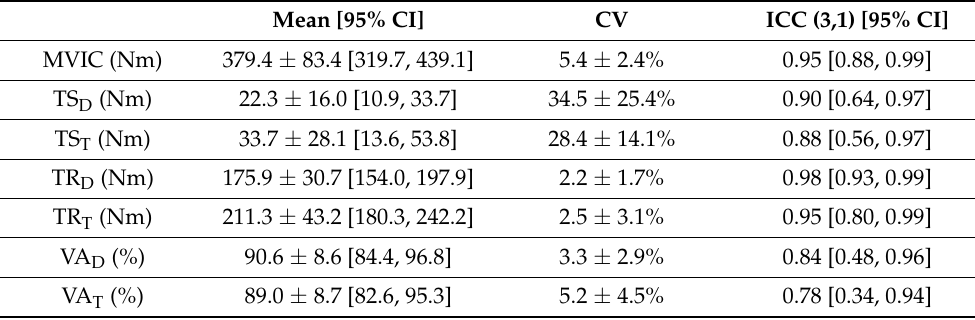
Table 1. Reproducibility and variability in voluntary and evoked torque measurements during assessment of quadriceps activation with paired and triple supramaximal electrical stimulation.